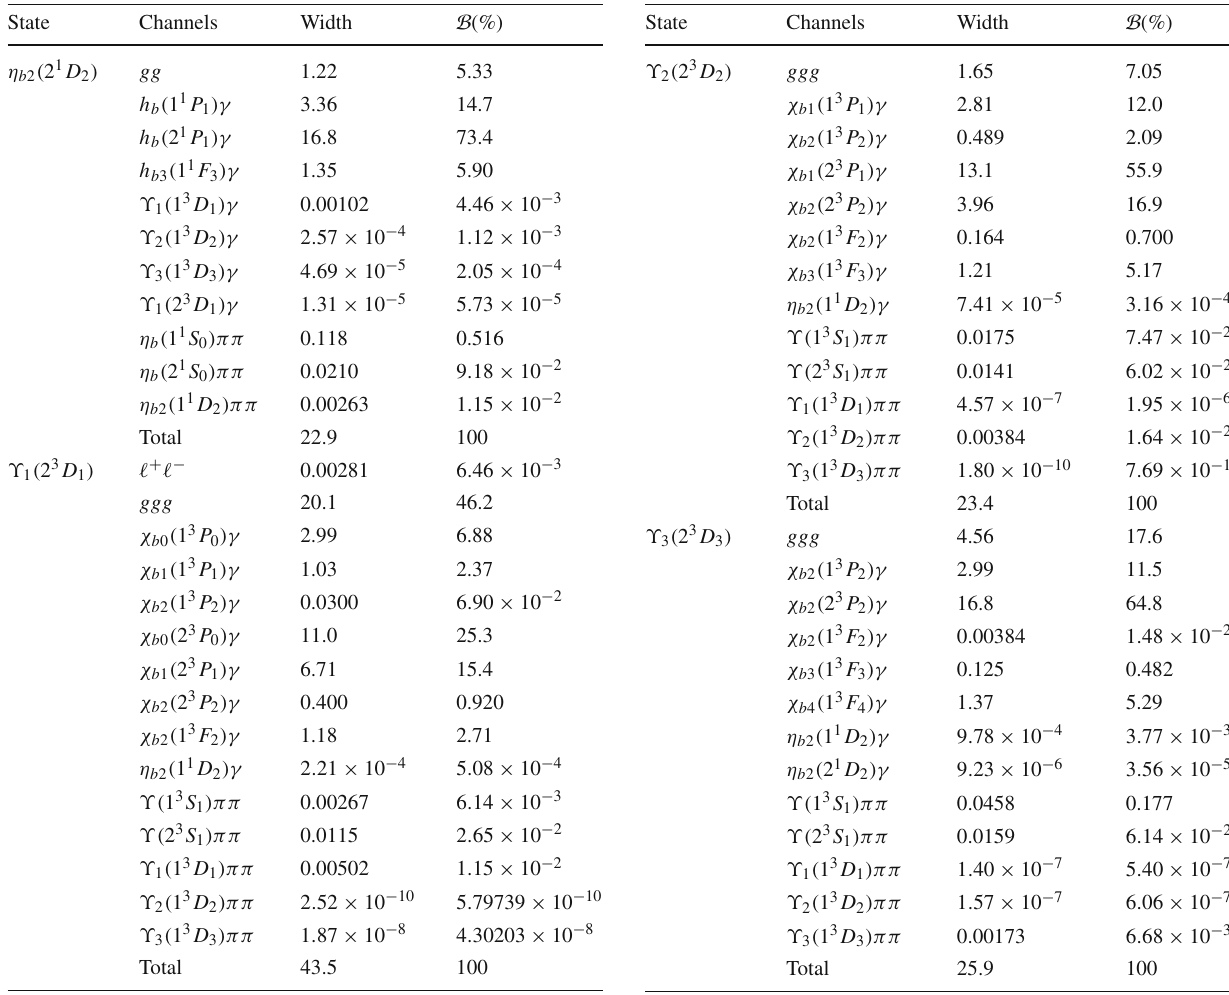
Table 12 Partial widths and branching ratios of annihilation decay, radiative transition, and hadronic transition and total widths for 2 3 D 2 and 2 3 D 3 bottomonium states. The width results are in units of